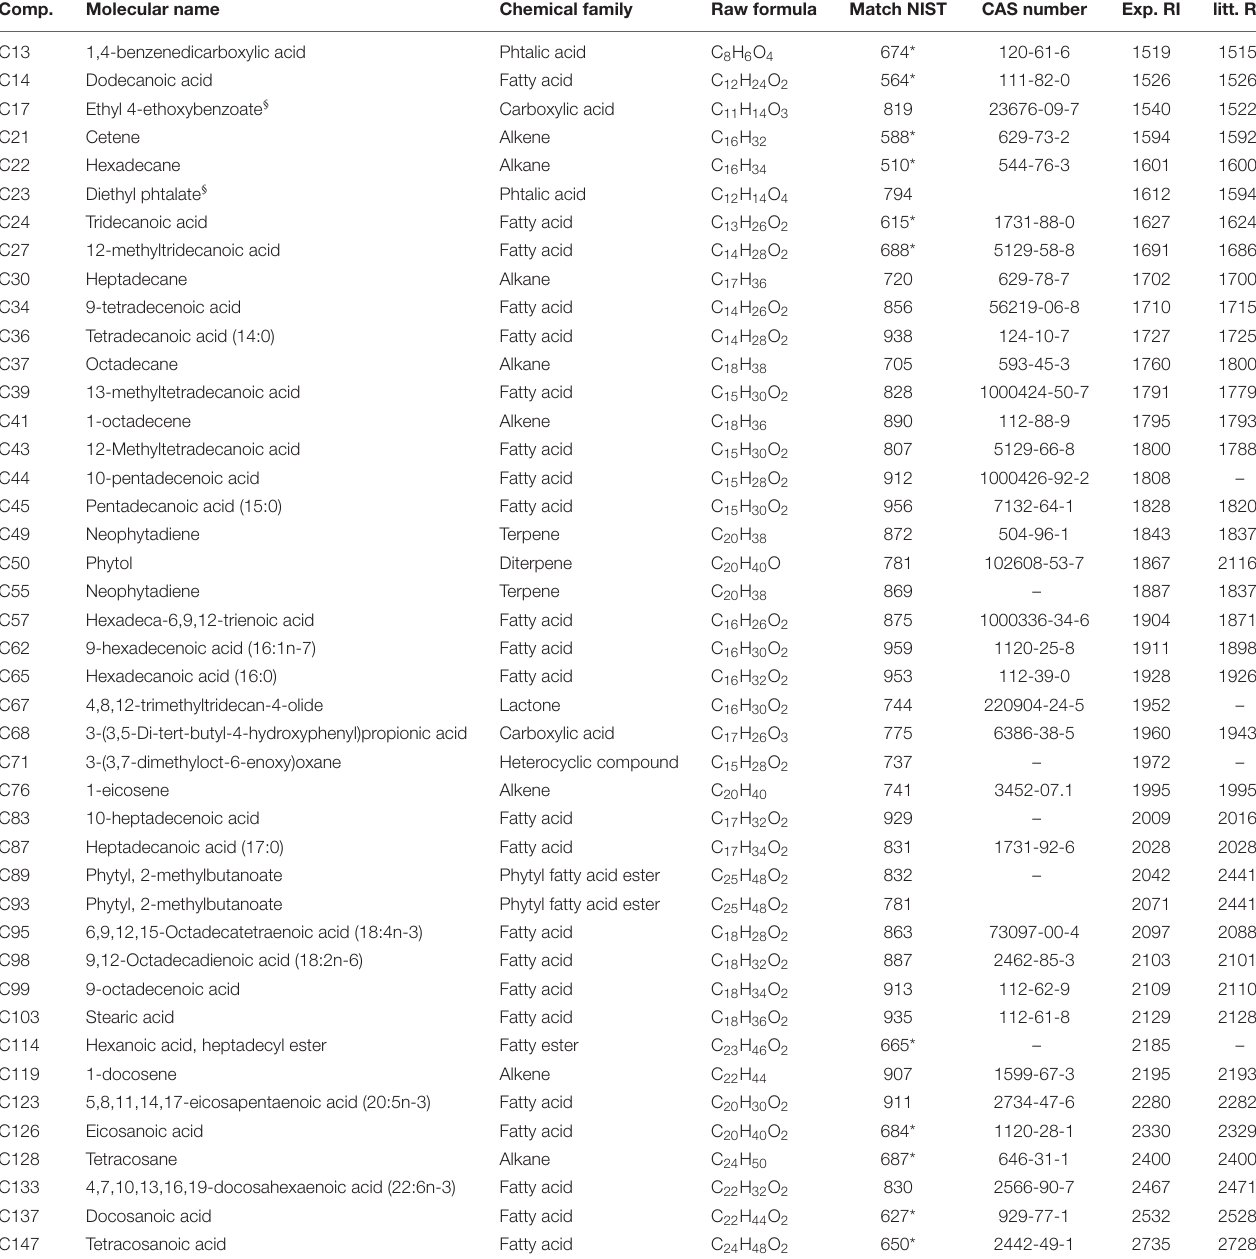
TABLE 2 | Annotated compounds in the CHCl 3 fraction of the MPB biofilm during the light exposure experiment (after data analyses and filtering).